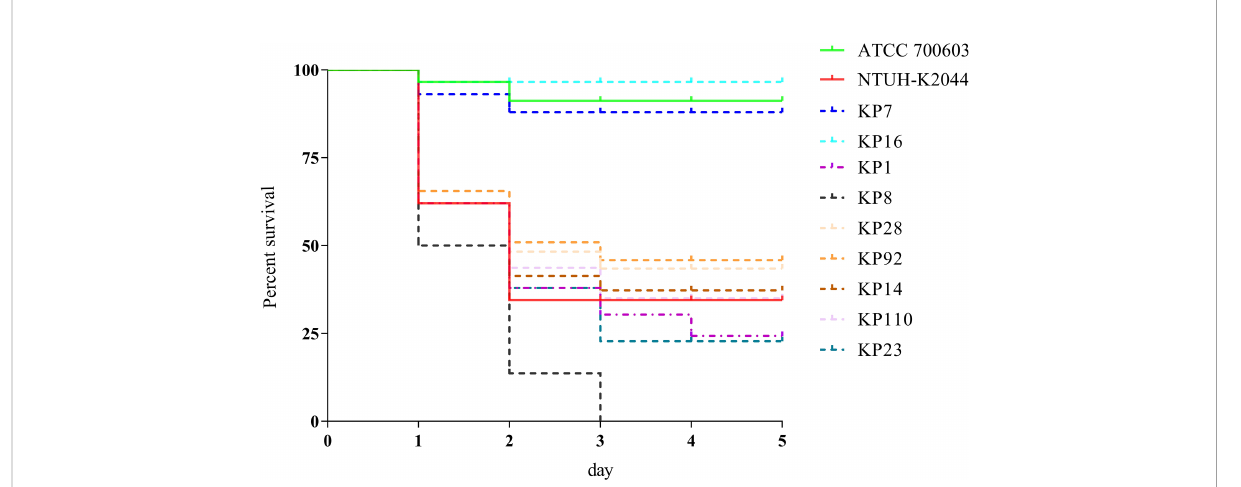
FIGURE 1 Evaluation of the virulence of KP isolates. Using a G. mellonella infection model, we investigated the virulence of 1 × 10 6 CFU of each KP strain (KP1, KP7, KP8, KP14, KP16, KP23, KP28, KP92, and KP110). NTUH-K2044 and ATCC 700603 were used as high- and low-virulence KP controls, respectively. The survival rates of KP7- and KP16-infected G. mellonella were similar with ATCC 700603, while those of KP1, KP8, KP14, KP23, KP28, KP92, and KP110 were similar with NTUH-K2044, indicating that they were hypervirulent.